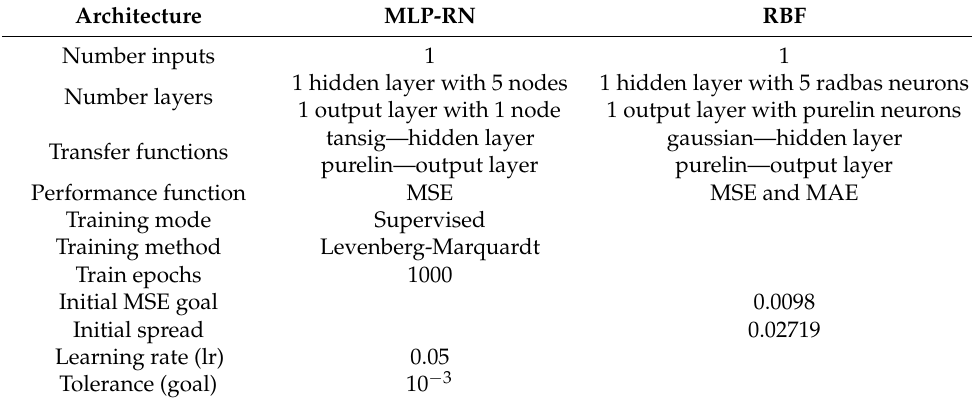
Table 1. Characteristics of NN models.